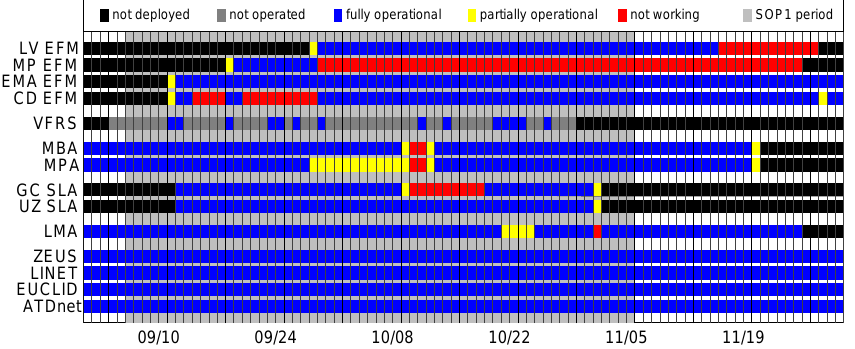
Table 2. Status of the instruments during HyMeX